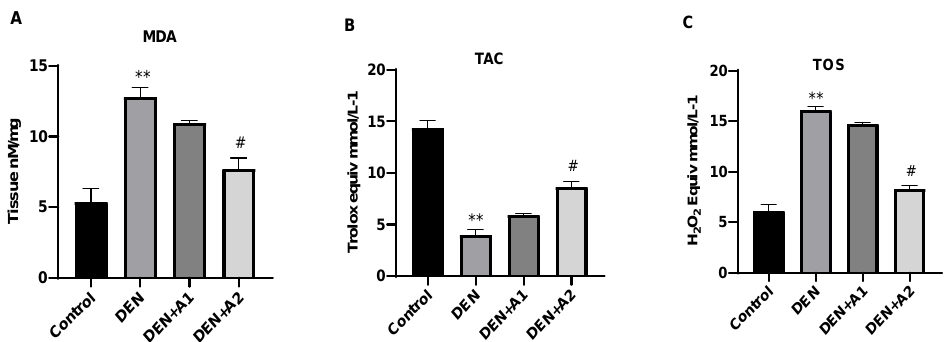
Figure 2. Effects of artichoke on ( A ) Malondialdehyde (MDA) levels (nM/mg), ( B ) Total Antioxidant Ca- pacity (TAC) (Trolox Equiv mmol/L − 1 ), and ( C ) Total Oxidative Status (TOS) (H 2 O 2 mmol Equiv/L − 1 ) levels in brain tissue ( n = 8). Data are presented as means ± SD, ** p < 0.001 vs. control group, # p < 0.05 vs. DEN group; DEN: diethylnitrosamine, A1: 0.8 g/kg artichoke, A2: 1.6 g/kg artichoke.